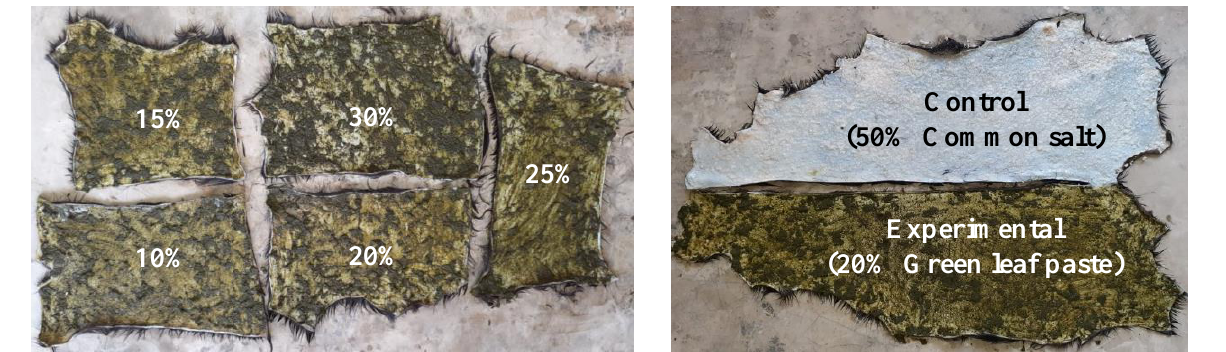
Figure 2. Preliminary experiment with green leaf paste Figure 3. Comparison between experimental and